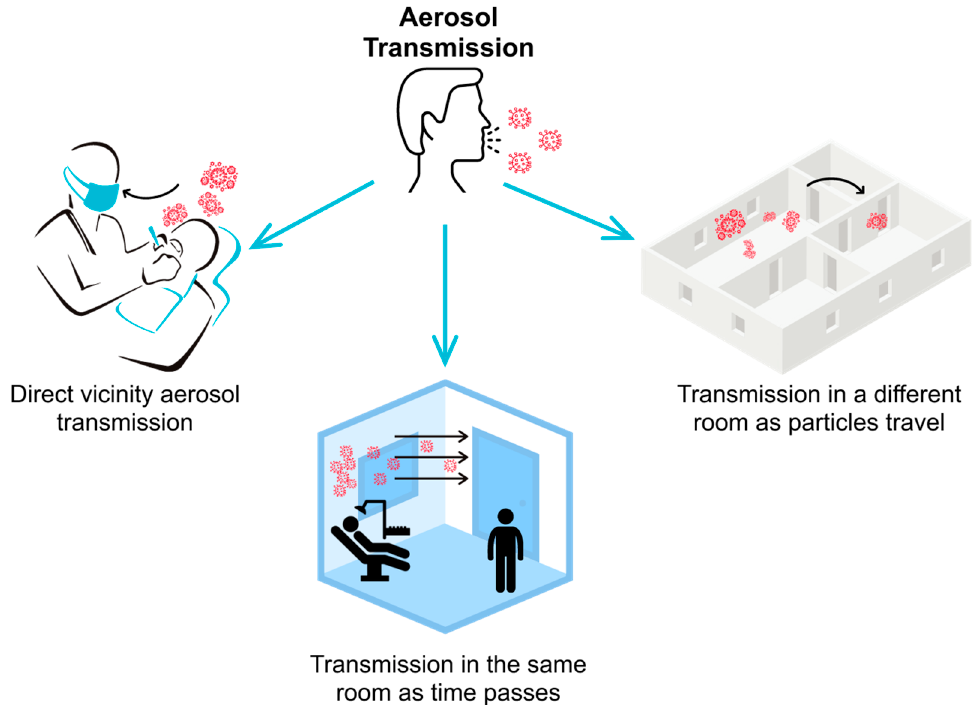
Figure 1. Aerosolized particles generated during dental operations can transmit infectious diseases via three paths: ( a ) direct-vicinity transmission (dental professionals while performing high aerosol-generating procedures); ( b ) same-room transmission as time passes (anyone who enters the room after the procedure); and ( c ) different room or location transmission (aerosolized particles can travel to different rooms or locations in the dental office, putting everyone in those locations at risk).